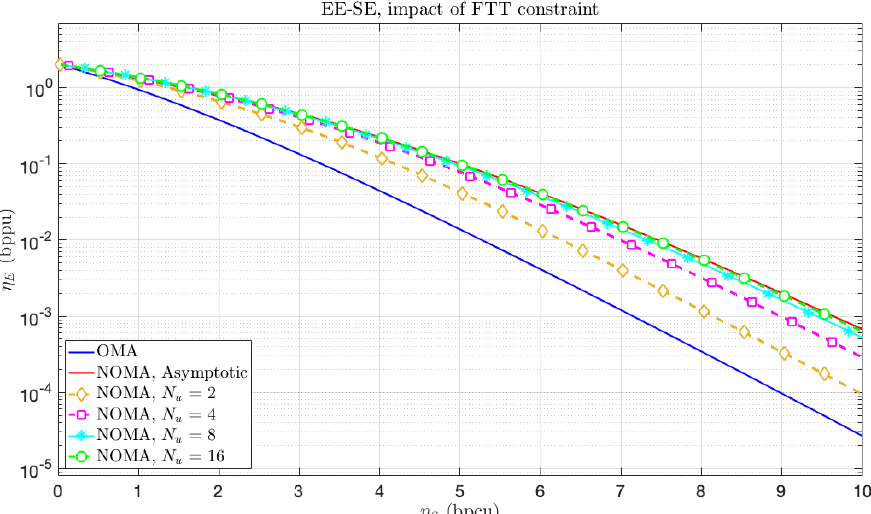
Figure 4. η E − η S trade-off for the baseline OMA (blue), the asymptotic NOMA (red) and for FTT models with N u ∈ { 2,4,8,16 }